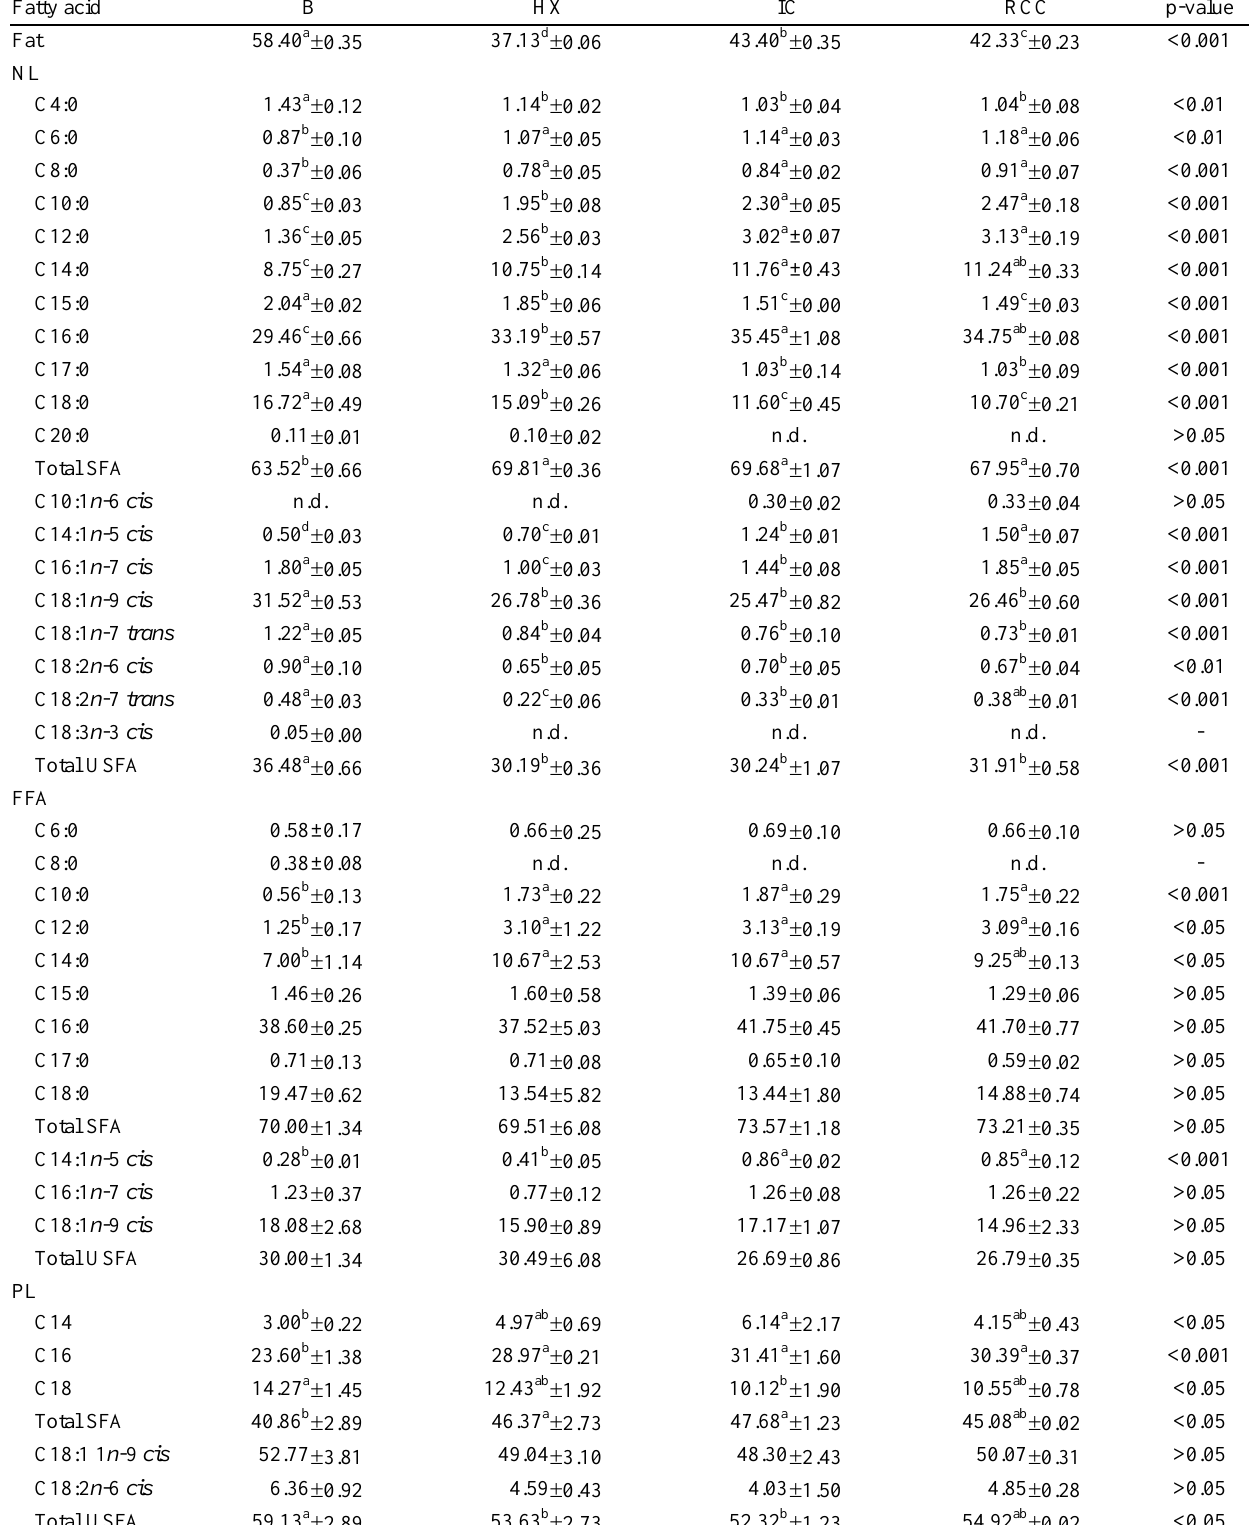
Table 4. Fat content (g/kg milk) and fatty acid composition (% of total fatty acid in each class of lipid) in neutral lipid (NL), free fatty acids (FFA) and polar lipid (PL) of milk from buffalo (B), Holstein cross (HX), Indigenous cattle (IC) and Red Chittagong